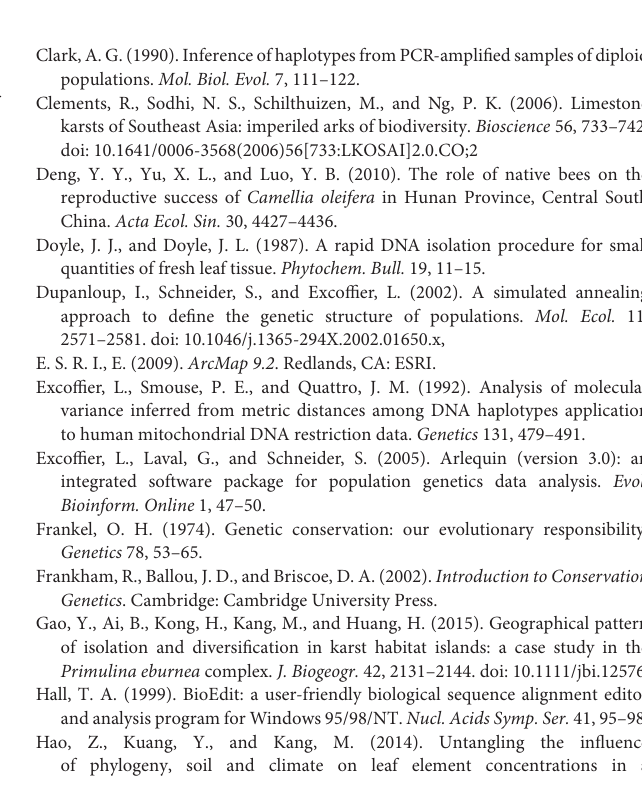
Figure S1 | Maximum Likelihood phylogenetic tree reconstruction for the C. flavida based on PAL sequences. Numbers at nodes represent the result of the ML bootstrap analysis. Nodes without numbers correspond to supports weaker than 70% BP. Double slashes on branches indicate branch length not in proportion. Figure S2 | Delaunay triangulation and Voronoï tessellation of the barrier analyses for C. flavida across the entire study area. Red points correspond to sampling sites. Barriers identified with the PAL dataset are dark red. Figure S3 | Delaunay triangulation and Voronoï tessellation of the barrier analyses across a portion of the study area corresponding to populations containing individuals with the group (var. flavida 1) identified using PAL sequences. Red points correspond to sampling sites; barriers identified with the PAL dataset are dark